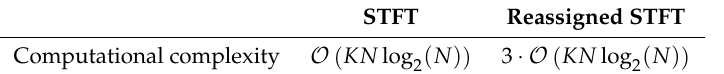
Table 2. Computational complexity for the STFT and the reassigned STFT in the N —amount of points in the FFT analysis, K = has to be applied for M —signal length in samples, and H —window shift in